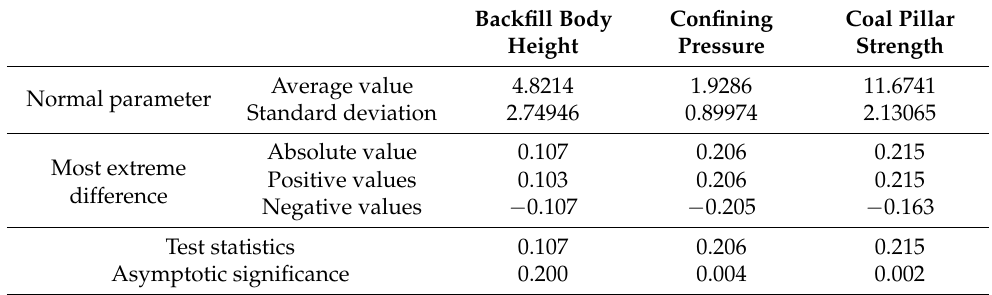
Table 5. Kolmogorov–Smirnov test.